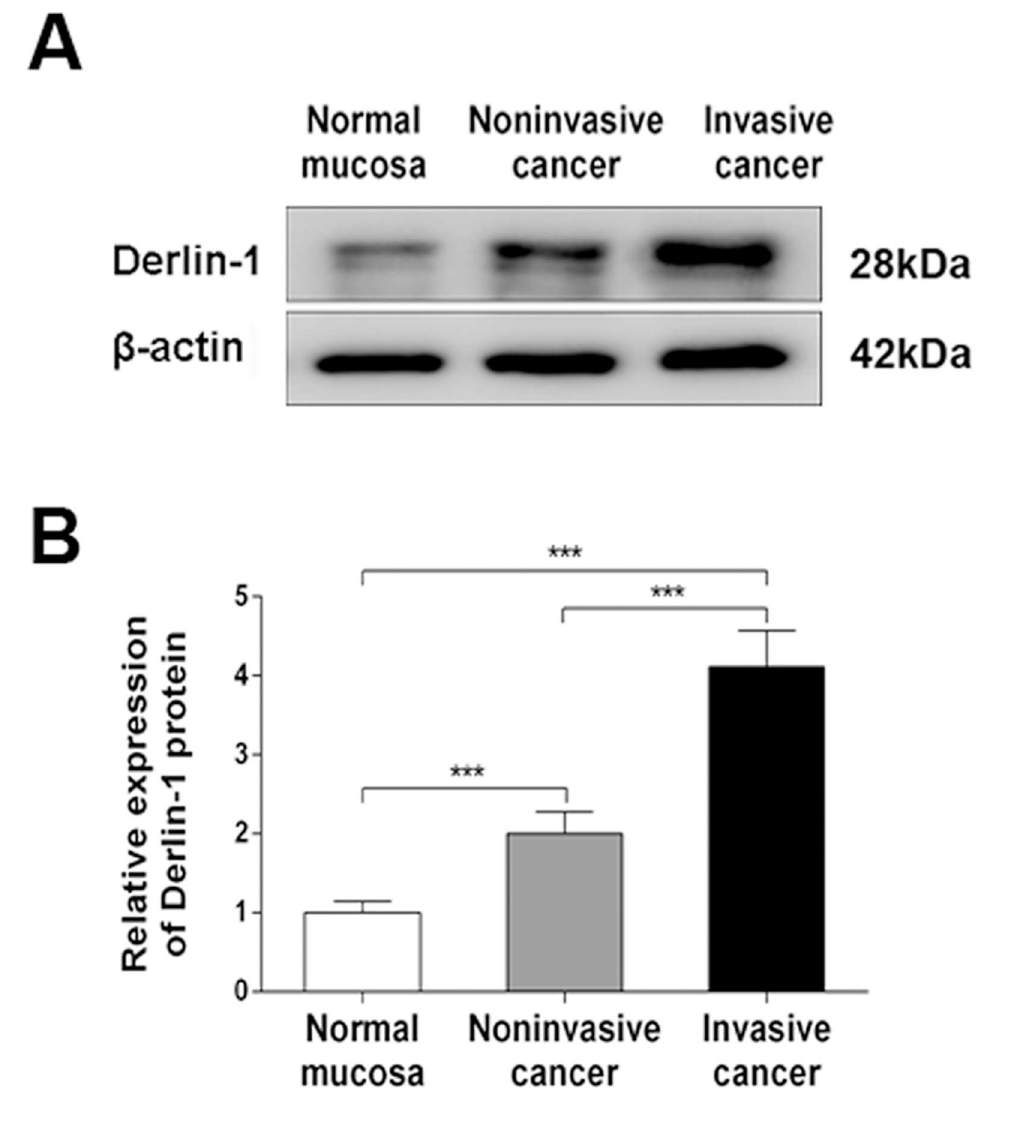
Fig 4. Expression of Derlin-1 protein in noninvasive and invasive bladder cancer tissues. (A) Derlin-1 expressionby western blotting. (B) Quantitative analysisof Derlin-1with respect to β -actinlevel. Data are expressedas the mean ± S.D., * P < 0.05, ** P < 0.01, *** P <